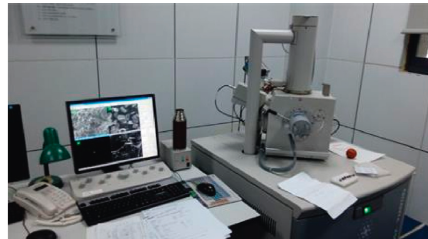
Figure 3: The Quante-250 scanning electron